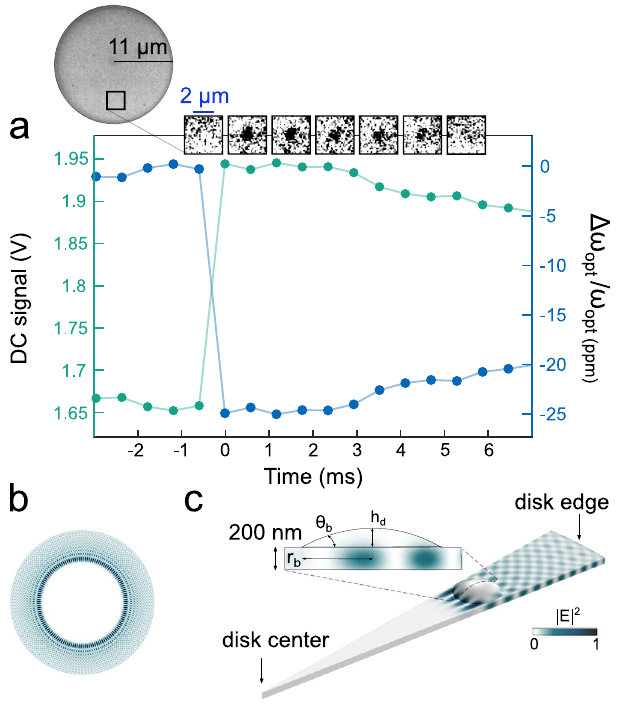
Fig.3|Mechanicalmeasurementofthenanodropletbythedisk.a Displacement pro fi leoftheRBM1foradiskof11 μ mradiusand200nmthickness. b RMSvelocity amplitude distribution for the same RBM1 over a disk slice where the droplet did land. The in-plane vibrations of the disk induce shear waves in the droplet that are attenuatedalongtheverticaldirection,whiletheno-slipconditionisimposedatthe solid – liquid interface. For the sake of illustrating the situation at t =0, the droplet contact angle was arti fi cially increased from 12° to 35°. c Phase of the experimen- tally measured output signal demodulated at the RBM1 frequency (yellow), acquiredduring thedropletlandingalreadyreported inFig.2a.Thephasechanges abruptly at time t =0 when the droplet lands. After impacting the disk surface, the droplet undergoes a damped oscillation that lasts about a microsecond and is hence not detectable with our time resolution. The mechanical resonance shift (after correction, see text) is reported in pink. A 1kHz bandwidth is employed as a compromise between sensitivity to mass adsorption (hundred of attograms) and time resolution (0.6ms). The black square open symbols are the mechanical resonance shifts calculated with FEM (see text).The gray square open symbols are FEM results corresponding to the two extremal scenarios associated with our uncertainty in the droplet contact radius (+200nm) and position on the disk sur- face